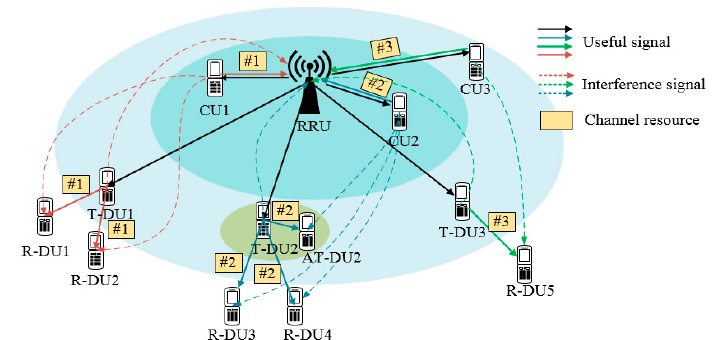
Figure 2. UE classification and channel multiplexing.